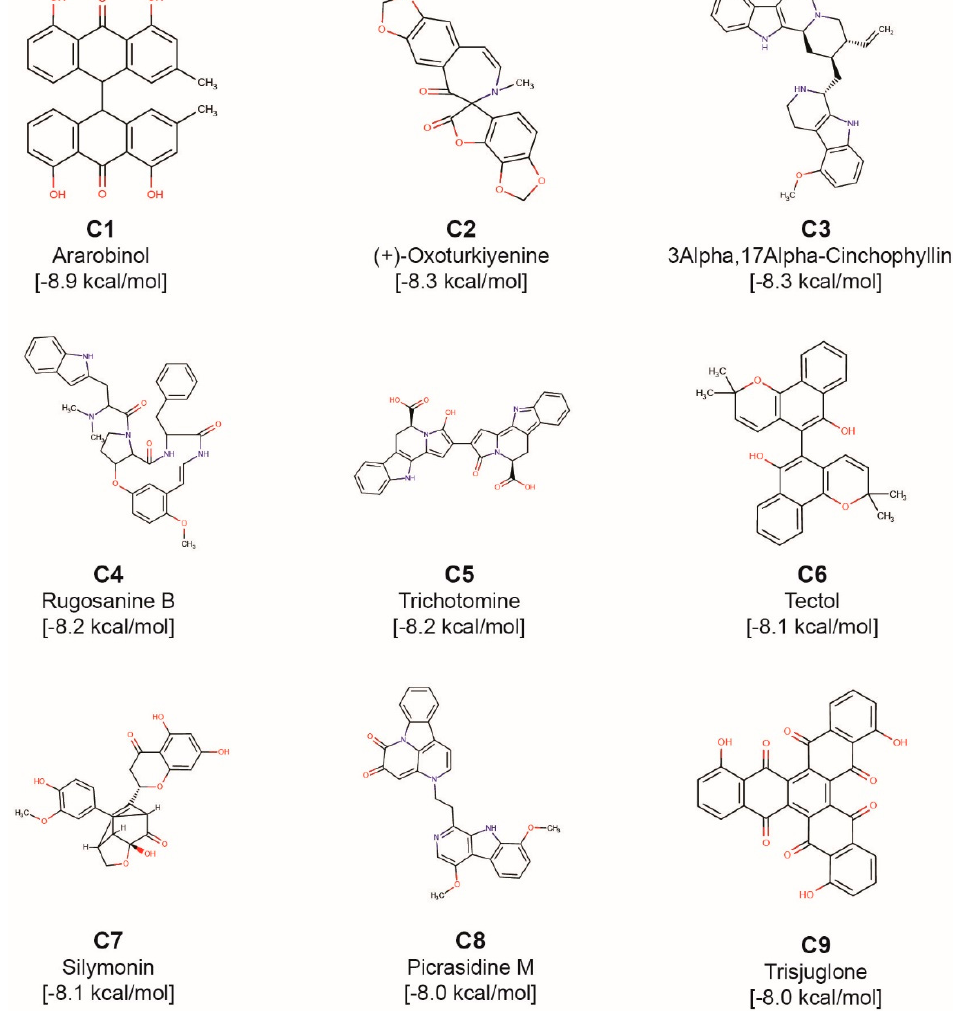
Figure 6. Molecular structures of the top 9 phytochemical inhibitors (compounds C1–C9 ) of cathepsin L. For each inhibitor, the figure shows the 2D structure, common name and docked binding energy of the ligand with cathepsin L.